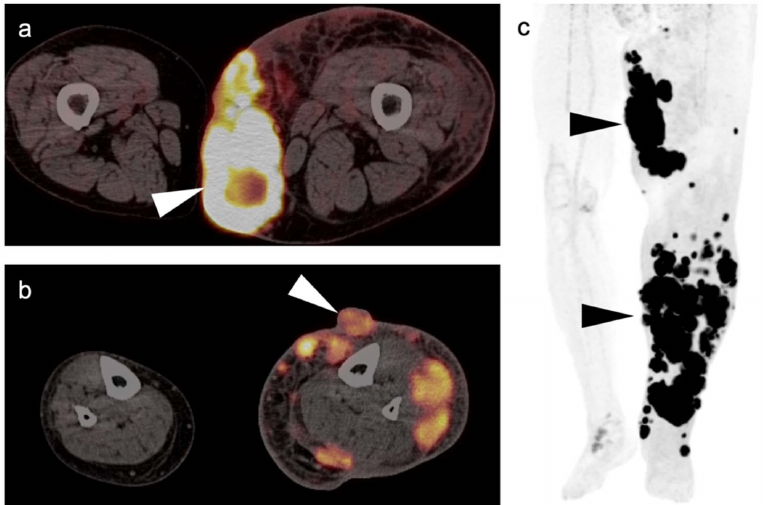
Figure 3. Melanoma of the left lower leg, metastatic to the lower extremity. ( a ) Axial FDG PET-CT images of the thighs show an intensely hypermetabolic tumor in the subcutaneous tissues of the left medial thigh (white arrowhead). ( b ) Axial FDG PET-CT image of the lower legs shows that the primary lesion is exophytic on the anterior left lower leg (white arrowhead), with multiple subcu- taneous metastases, some extending into the muscles. ( c ) FDG PET maximum intensity projection (MIP) image demonstrates the intensity of metabolic activity throughout the tumor in the left lower extremity (black arrowheads).